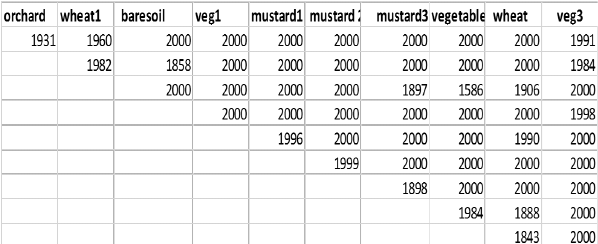
Table2. Confusion Matrix using RF